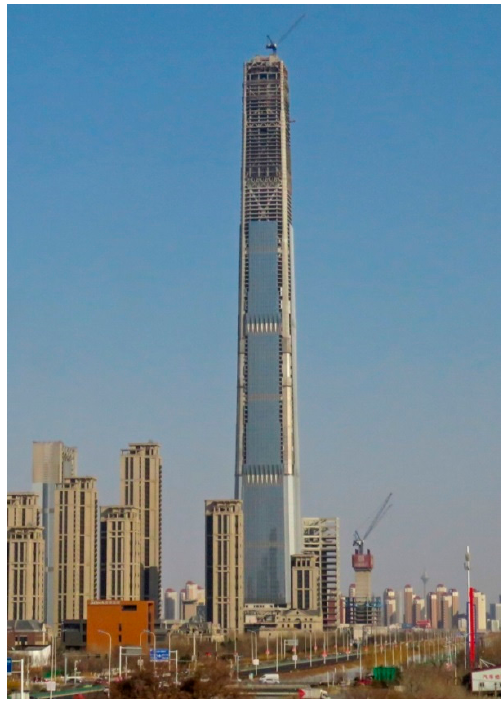
Figure 4. Goldin Finance 117 in Tianjin (Source: Wikipedia).